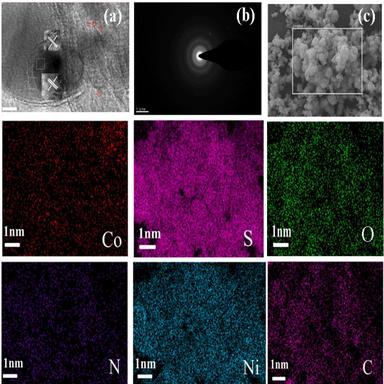
(a) HRTEM image, (b) SAED image of Co-NC and (c) SEM image and corresponding EDS elements mapping of NiS@Co-NC.